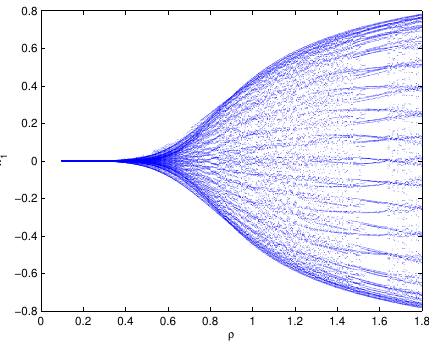
Figure 3. Bifurcation figure of system (95): ρ versus w 1 . The bifurcation value ρ 0 ≈ 0.6.